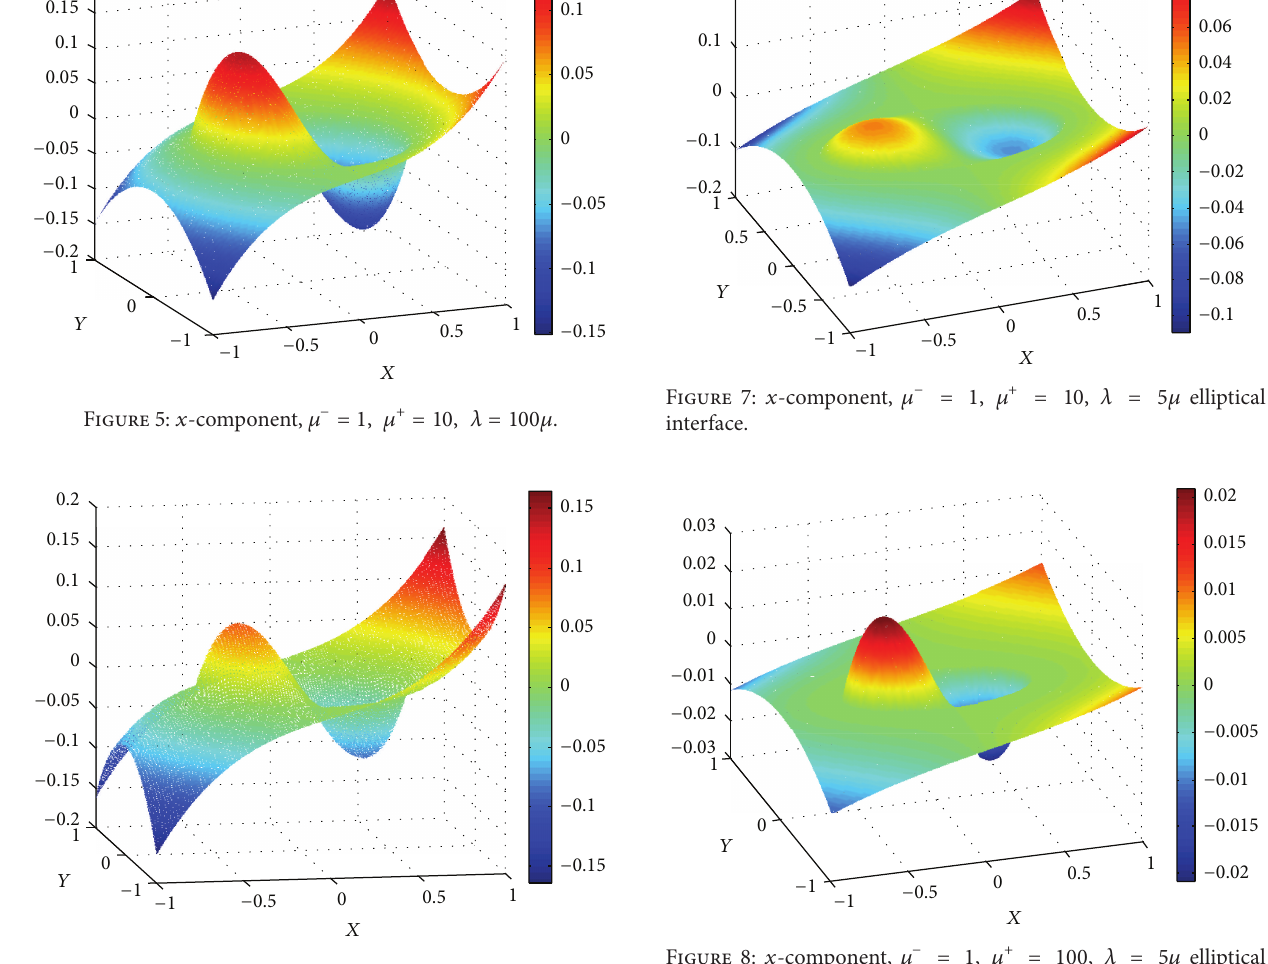
Figure 6: 𝑥 -component, 𝜇 − = 1, 𝜇 + = 10, 𝜆 = 1000𝜇 .